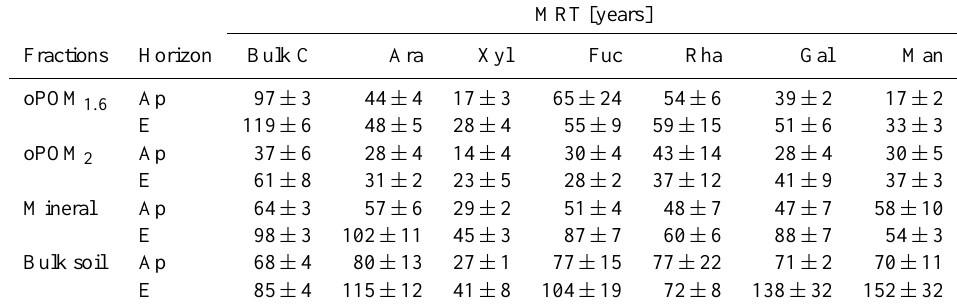
Table 2. Calculated MRT of total and individual sugar carbon in density fractions and bulk soil. Means and standard error ( n =